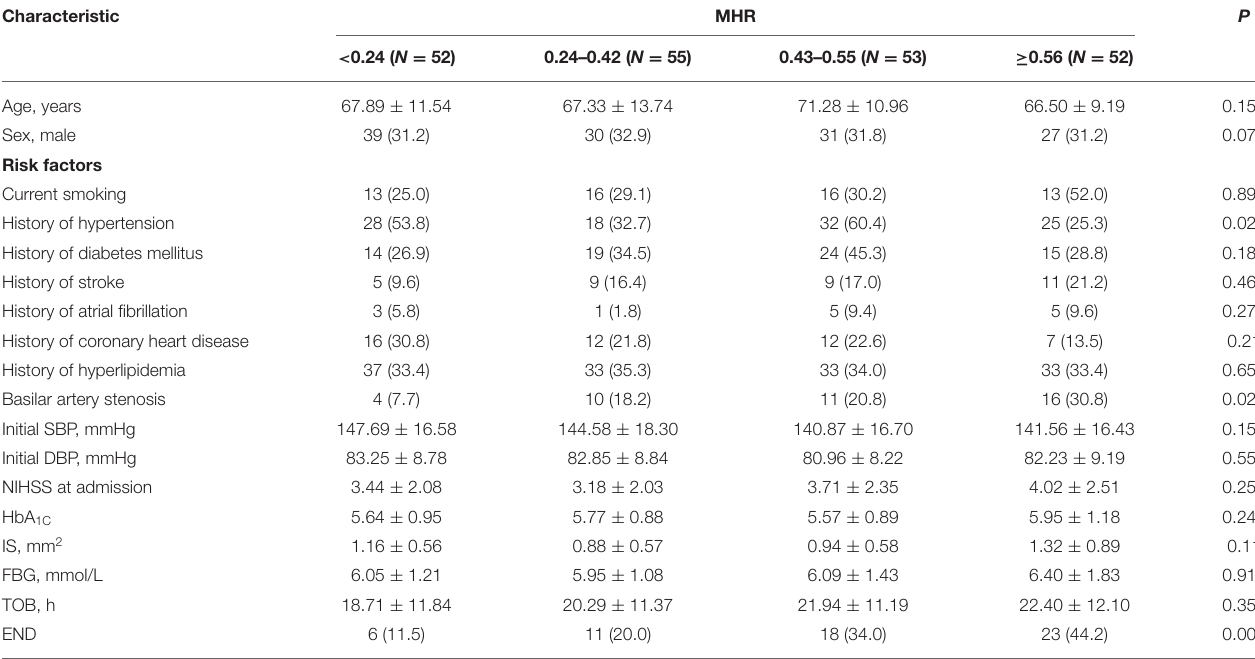
TABLE 1 | Characteristics of patients with isolated pontine infarction according to monocyte to high-density lipoprotein ratio quartile. Characteristic